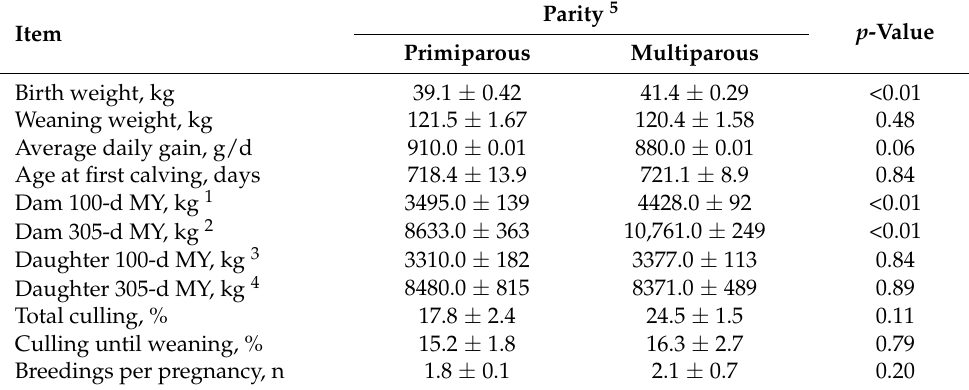
Table 1. Effect of parity in the performance of cows and their